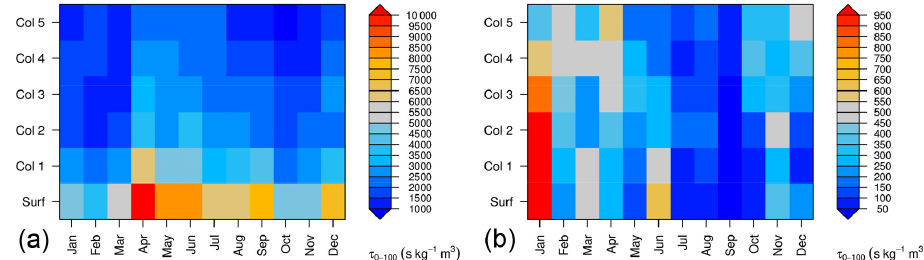
Figure 9. Annual cycle of FLEXPART-derived total surface residence time over land for different vertical arrival columns above Jungfrau- joch: (left) for land surfaces north of 30 ◦ N and (right) for land surfaces south of 30 ◦ N.